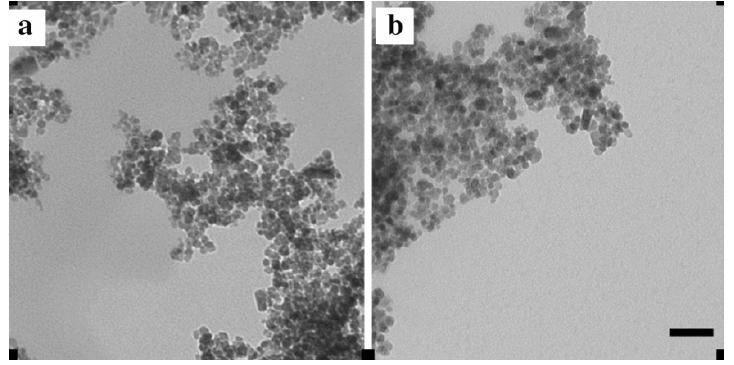
Figure 1. TEM images of the 200 nm plain (a) and 200 nm penetratin-functionalised (b) NPs. [Scale bar = 100 nm].